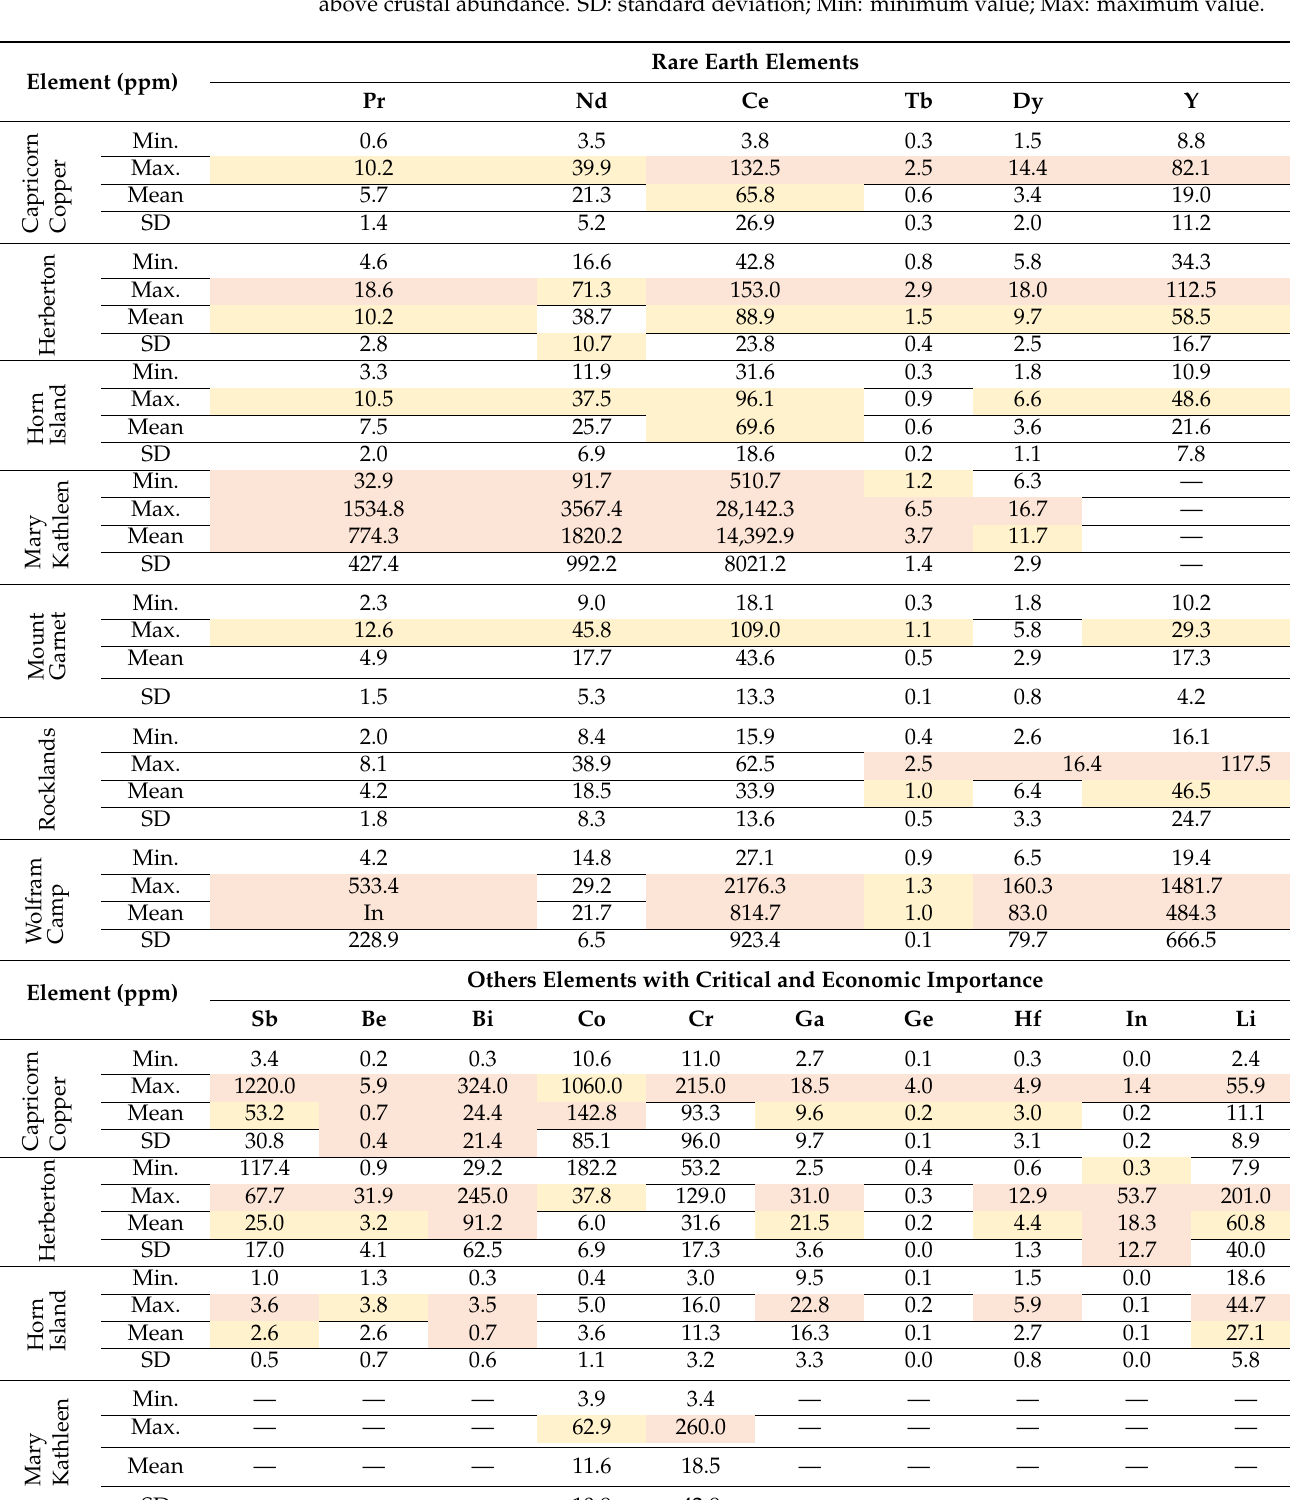
Table 5. Summary statistics of the elements classified as critical or with high economic relevance in each region from the Chilean data used in this study. Highlighted figures indicate a concentration above crustal abundance. SD: standard deviation; Min: minimum value; Max: maximum